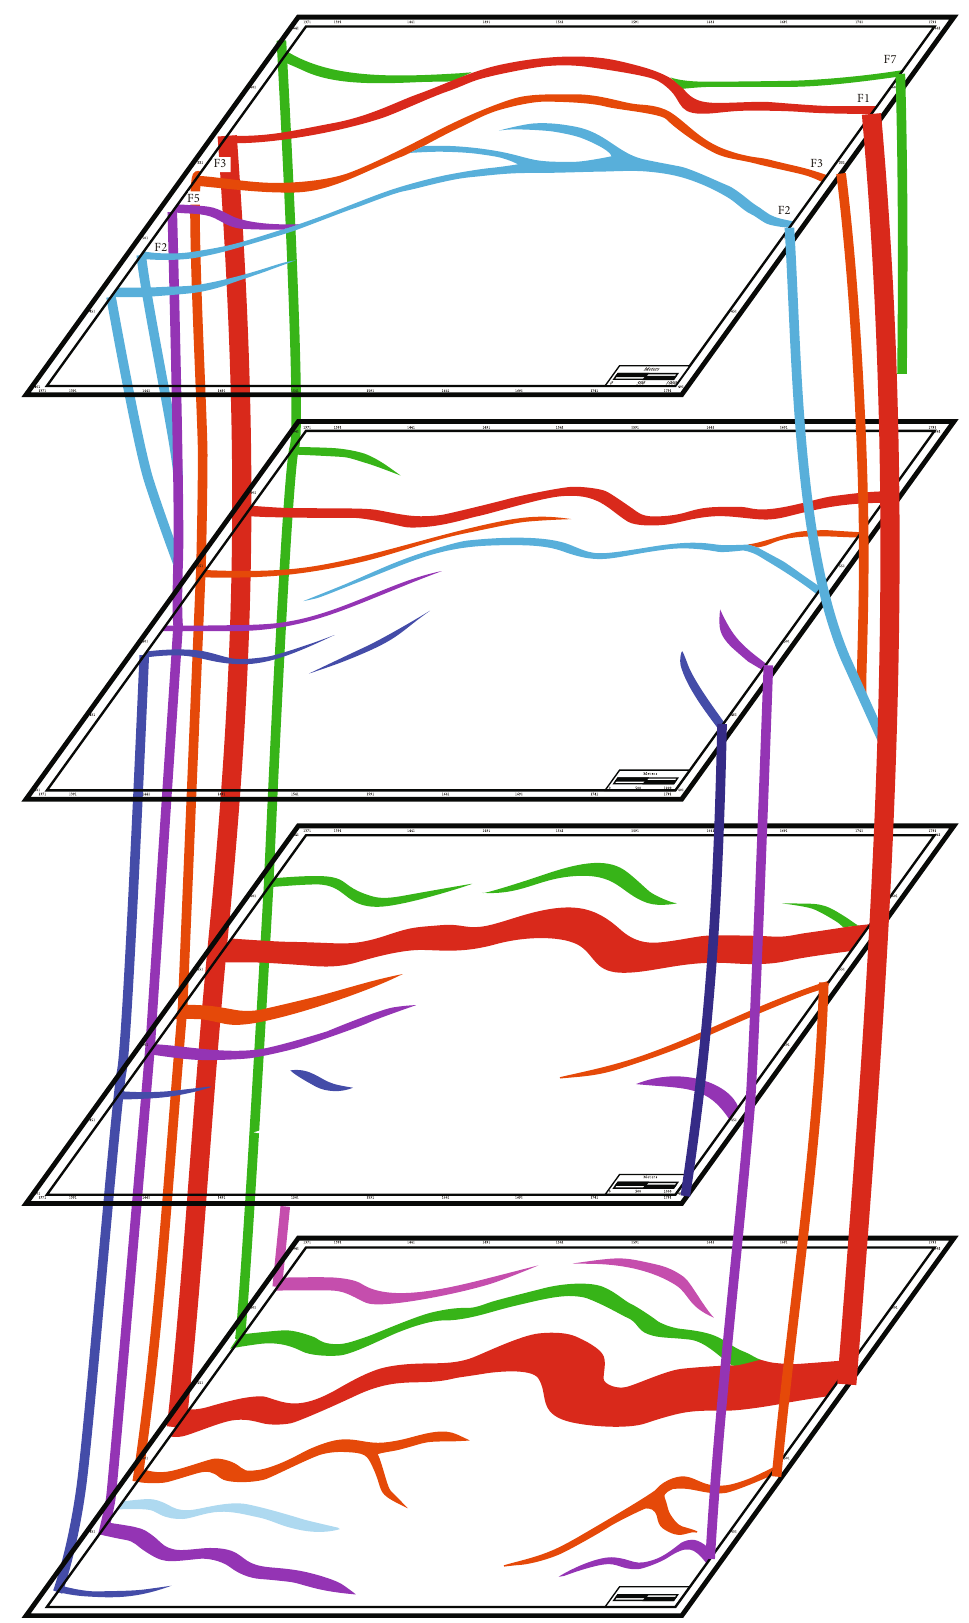
Figure 7: Combined patterns in space of Zhuangnan fault